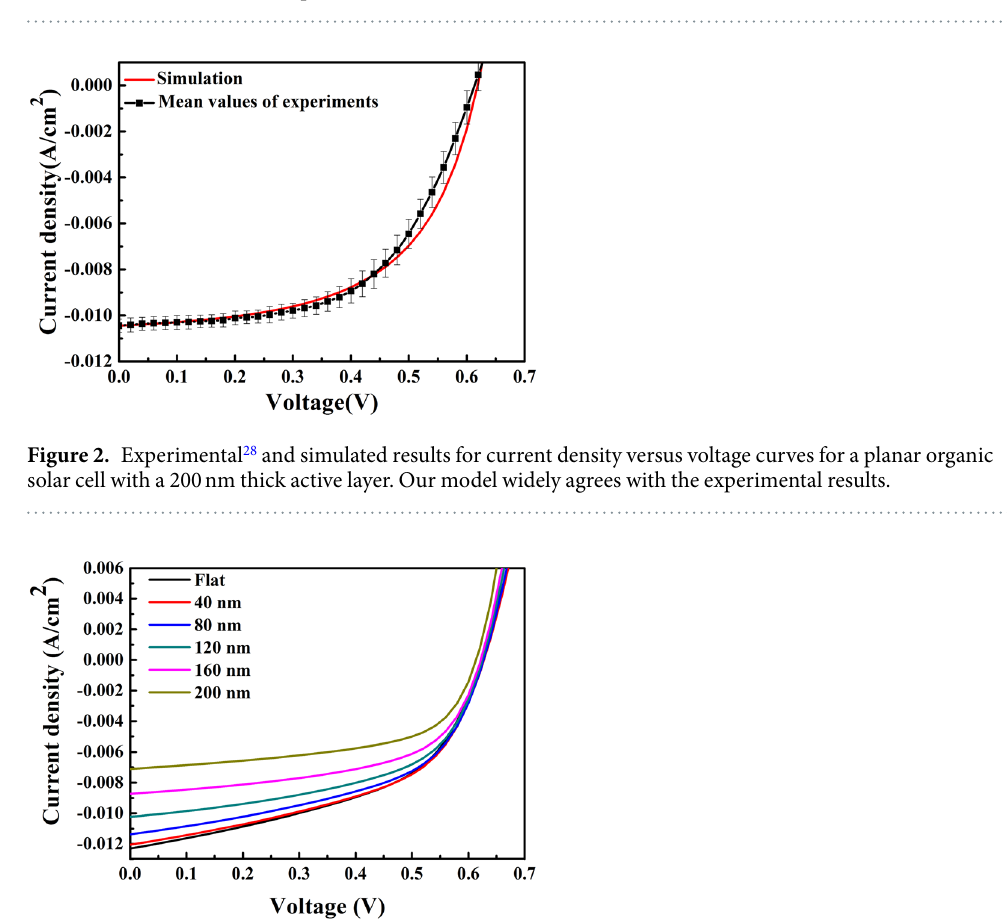
Table 1. Electrical simulation parameters.